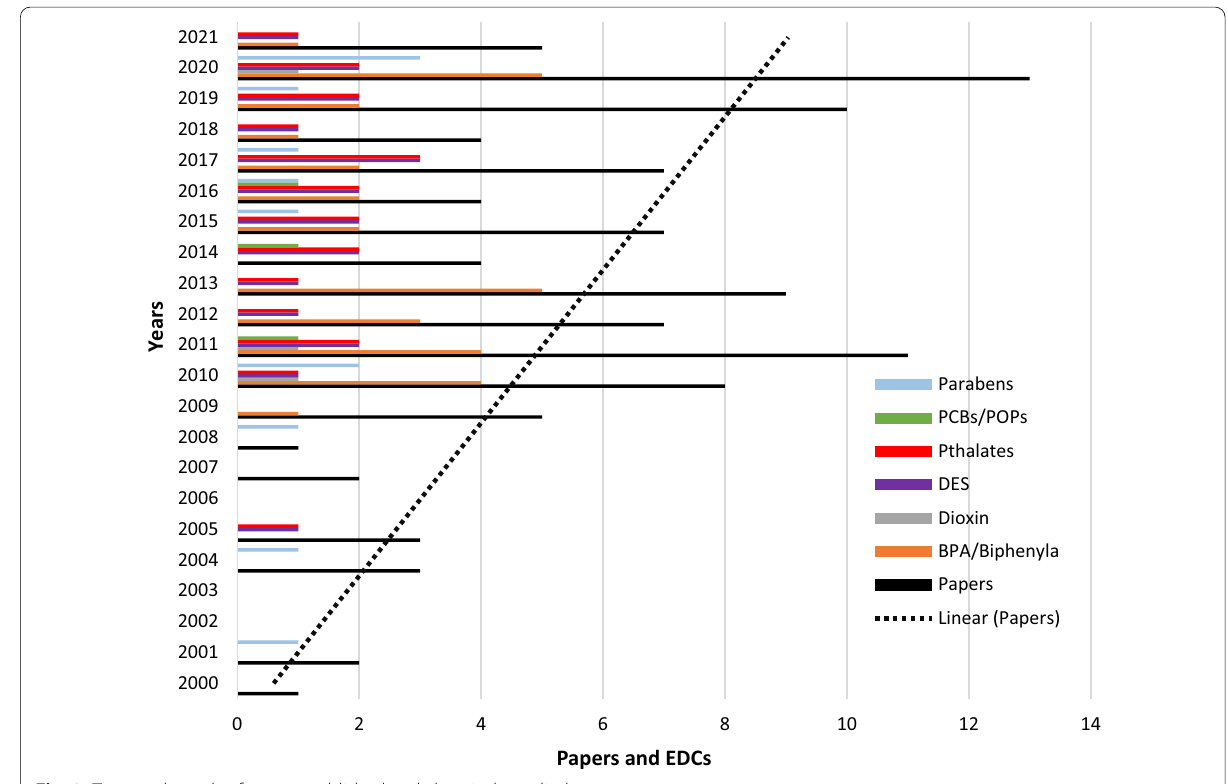
Fig. 2 Temporal trends of papers published and chemicals